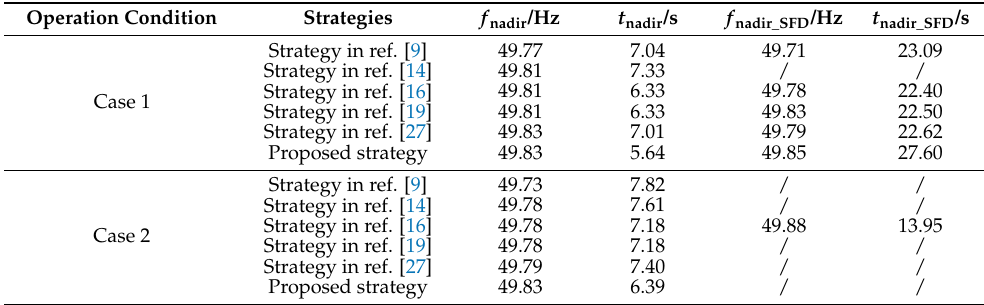
Table 9. Simulation results of different control strategies based on the operating conditions of Case 1 and Case